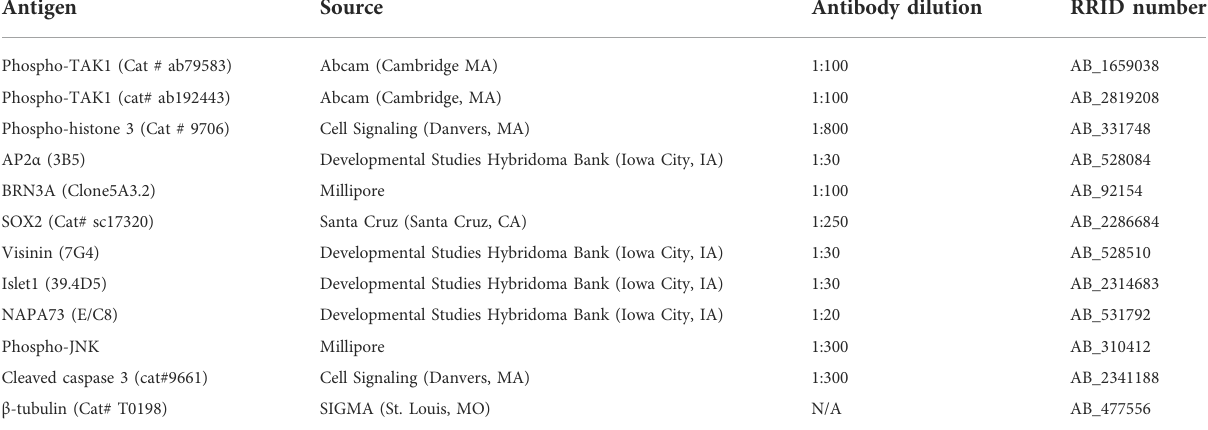
TABLE 1 Antibodies used in